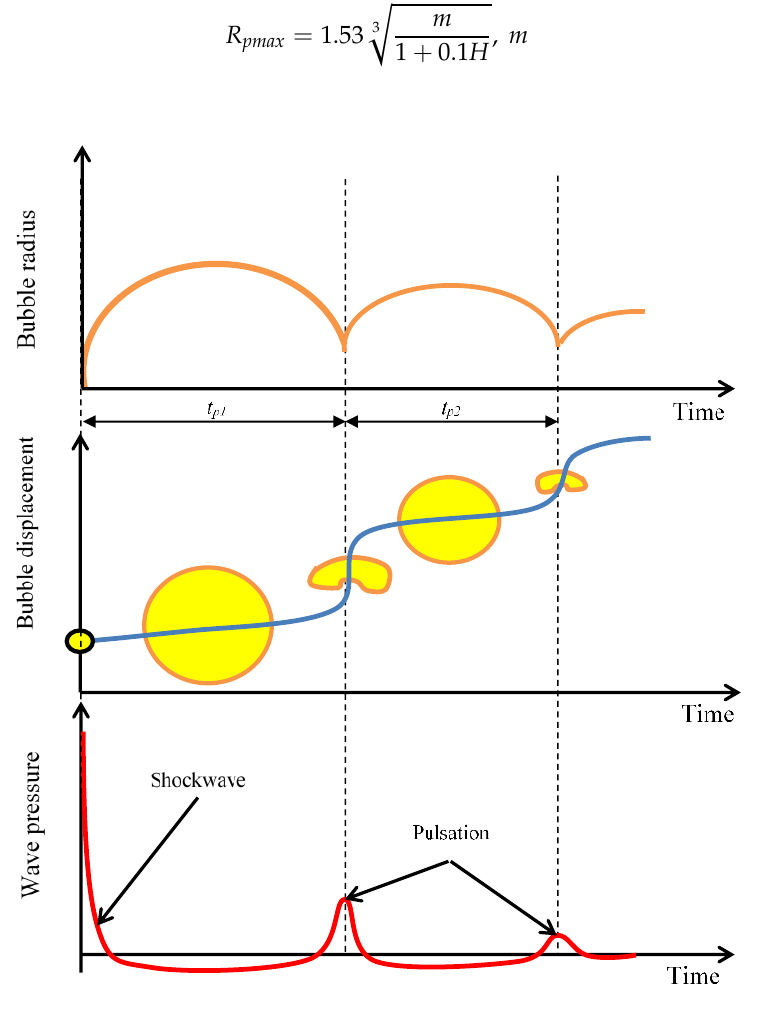
Figure 1. Diagram of the underwater explosion.